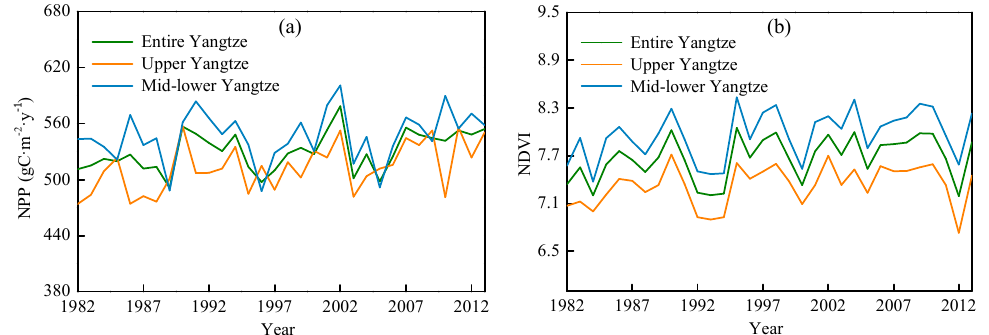
Figure 5. The annual mean forest NPP ( a ) and accumulated NDVI ( b ) in the Yangtze River basin during the period 1982–2013.